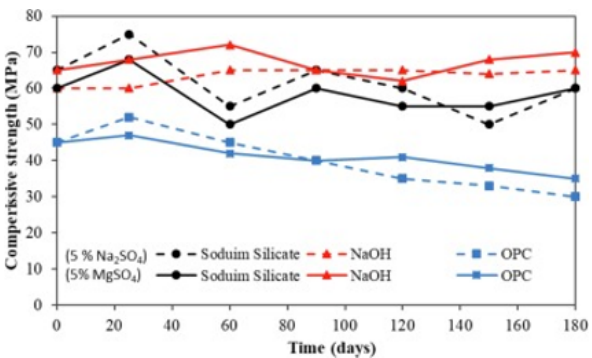
Figure 11: Compressive strength of fly ash activated with